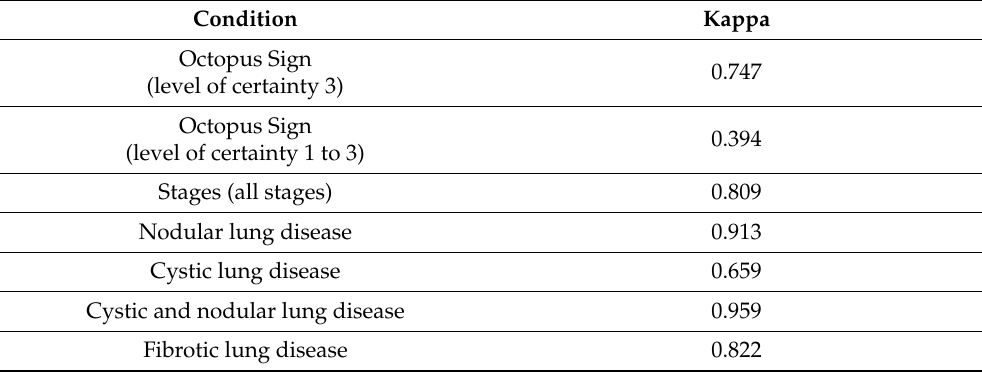
Table 1. Interrater agreement for different